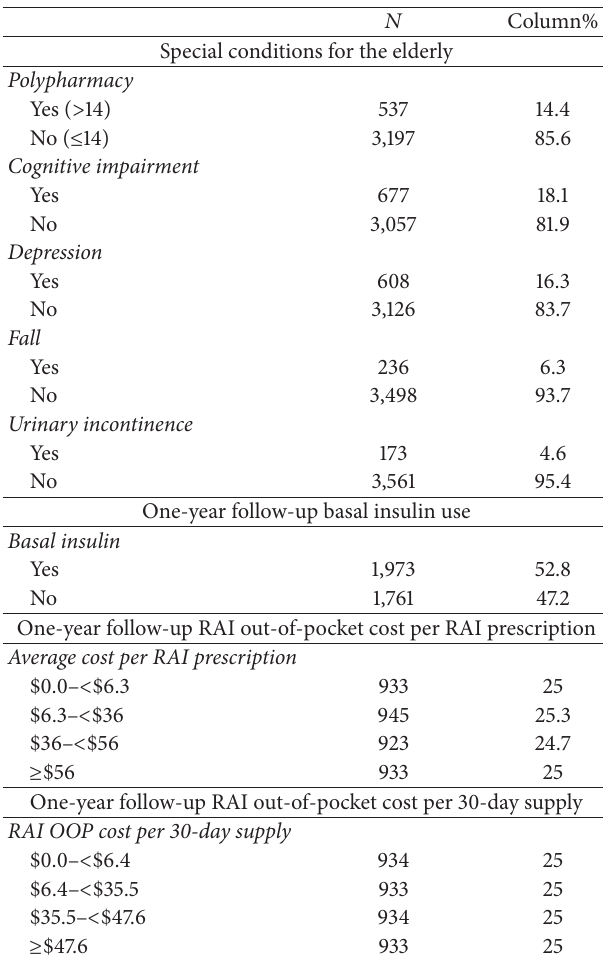
Table1:Characteristicsofelderly( ≥ 65years)Medicarebeneficiaries with type 2 diabetes mellitus who newly added rapid acting